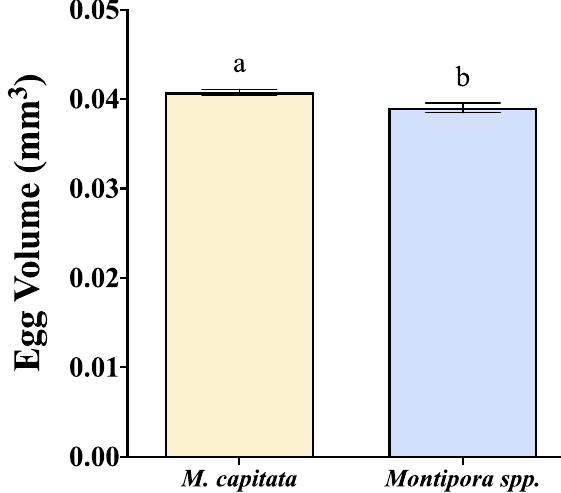
Figure 3. Egg volume compared between M. capitata and Montipora spp . The difference in egg volume (mm 3 ) between Montipora capitata and Montipora spp . on night of spawning after bundles had broken apart and hydrated for 30 min. The mean volumes were similar; however, there was greater variation in the volume of Montipora spp . eggs, possibly leading to the significant difference (n = 564 M . capitata , n = 564 Montipora spp ., p = 0.0002, Welch’s t = 3.791). Error bars are SEM, and different letters above error bars indicate significant